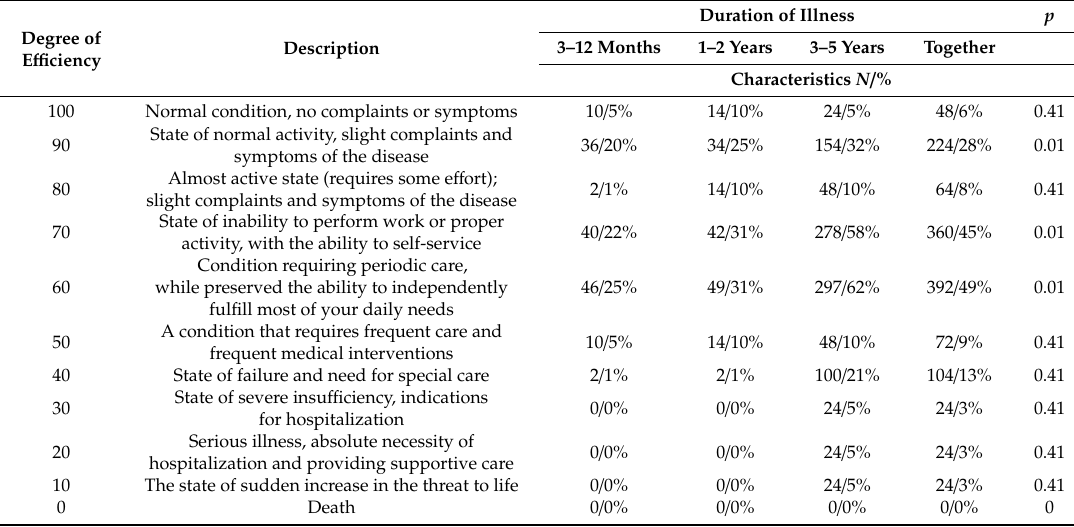
Table 3. The Karnofsky performance status.